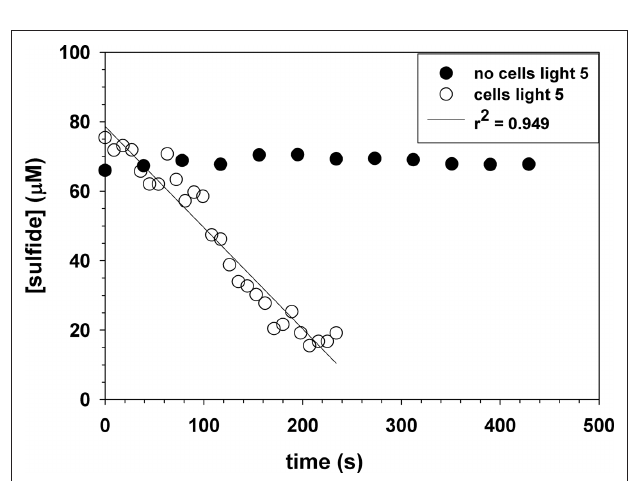
2 Figure 5 | representative plot for the photo oxidation of sulfide in the presence of C. tepidum cells during stationary growth phase with 5 μmol photons m − 2 s − 1 of light intensity. The control with no cells shows no sulfide